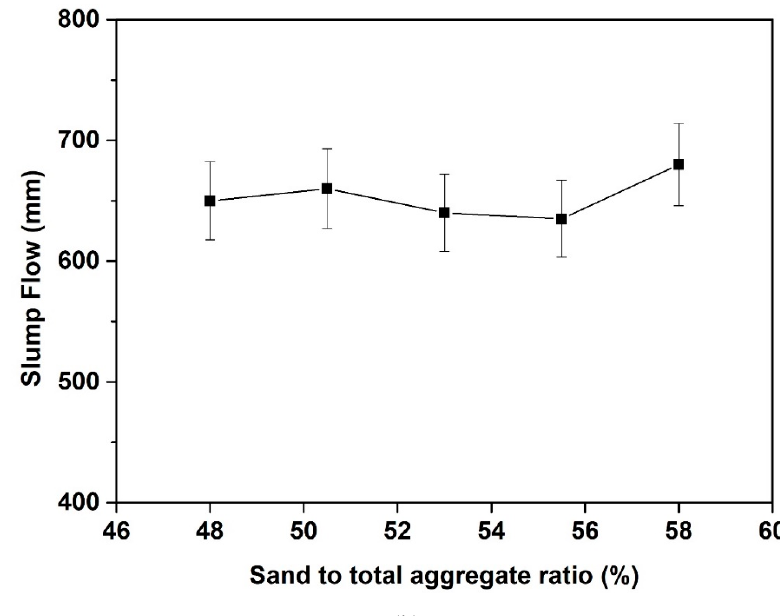
Figure 7. Influence of aggregate volume fraction ( a ) and sand to total aggregate volume ratio ( b ) on slump flow of fresh concrete mixtures upon mixing.